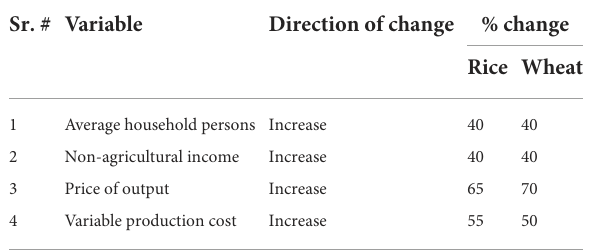
TABLE 4 Adaptation technology related to crop management used for crop models (DSSAT and PSIM) to cope with the negative impacts of climate change during mid-century (2040–2069).